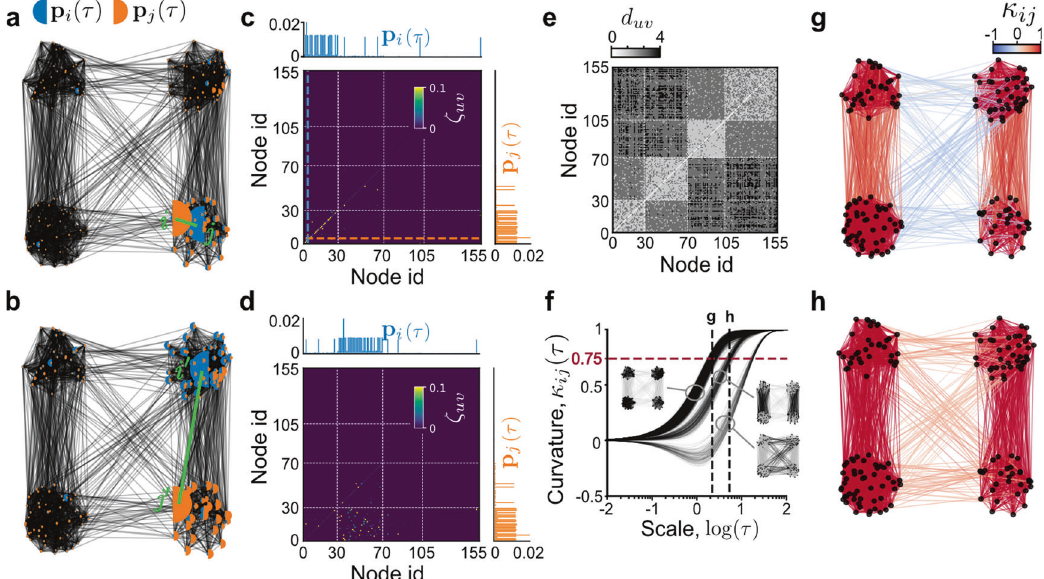
Fig. 1 Dynamical Ollivier – Ricci curvature capturing the spreading of diffusion processes. a Snapshot at time log τ ¼ 0 : 15 of a pair of diffusion measures p i ( τ ) and p j ( τ ) started at nodes i , j of a stochastic block model network (with four clusters of sizes 30, 40, 35, 50 and respective edge probabilities 0.7, 0.8, 0.9, 0.6 within clusters, and 0.1, 0.02 between clusters). When i and j are in the same cluster, the measures overlap signi fi cantly. The size of half-circles is proportional to the amount of mass on the respective nodes. b For i 0 ; j 0 in different clusters the measures remain largely disjoint. c Optimal transport plan ζ ( τ ) superimposed with p i ( τ ), p j ( τ ). When i , j (coloured dashed lines) lie in the same cluster only diagonal elements ζ uu are positive, meaning only geodesics within a cluster transport signi fi cant mass. The white dashed lines correspond to the four clusters. d When the diffusions started at nodes i 0 and j 0 in different clusters only entries ζ uv with u and v in the corresponding clusters have signi fi cant nonzero weight. e Geodesic distance matrix d uv showing the block structure of the network. f The evolution of the edge curvatures κ ( τ ) (Eq. (2)) against time. There are three distinct curvature bundles and in the insets we manually highlighted the edges to reveal their position in the graph. The shade of grey within the bundles re fl ect the density of edges. Here κ ij ( τ ) ≃ 0.75 marked by the red dashed line indicates scales when local mixing occurs between the corresponding diffusion pairs. The dashed vertical lines show two such scales (log τ ¼ 0 : 15 ; 0 : 43). g , h Graph edges coloured by the curvature reveals clusters at the two